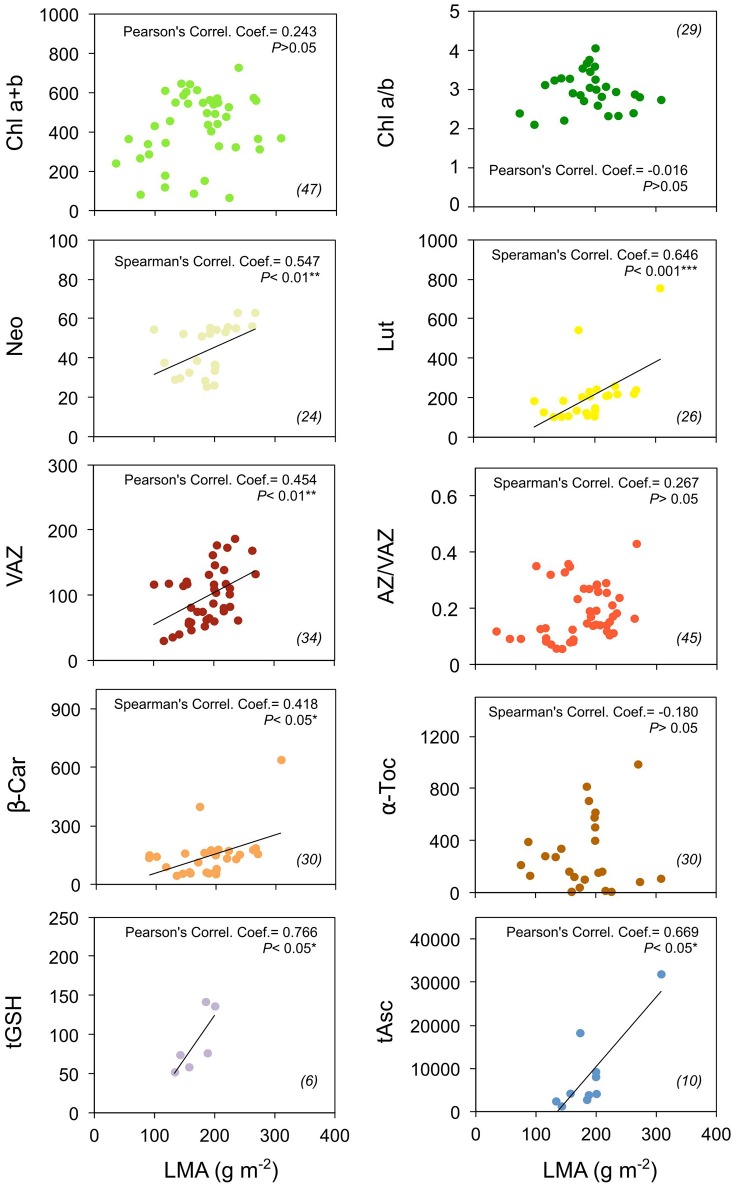
Photosynthetic pigment and antioxidant contents in relation to leaf mass area (LMA) of “non-stressed” Mediterranean plants. Pearson's (or Spearman's for non-normally distributed data) correlation coefficient and significance, and number of data (in brackets) are shown for each panel. Units are as in Figure 1. Asterisks denote the extent of significance. Only predawn data were included for this analysis.